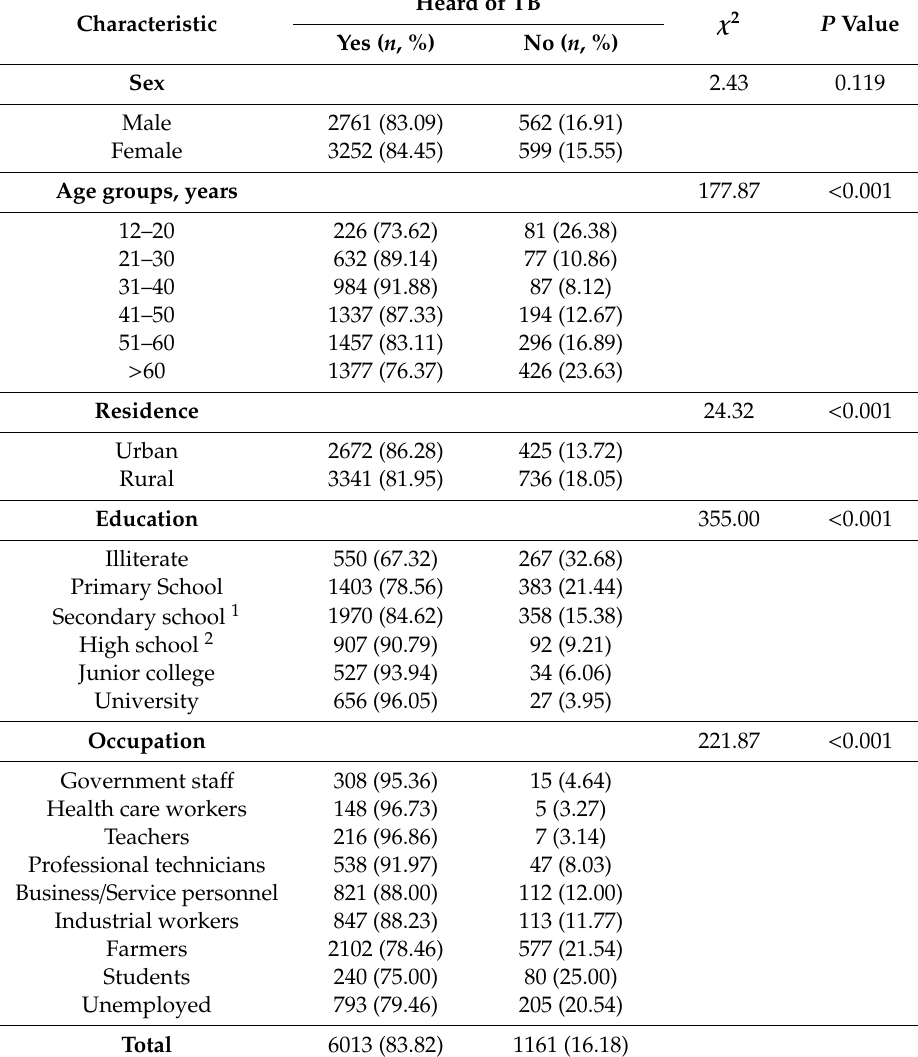
Table 2. Comparison of the general tuberculosis (TB) awareness rate among respondents with di ff erent characteristics in Zhejiang Province, China from October 2018 to December 2018.